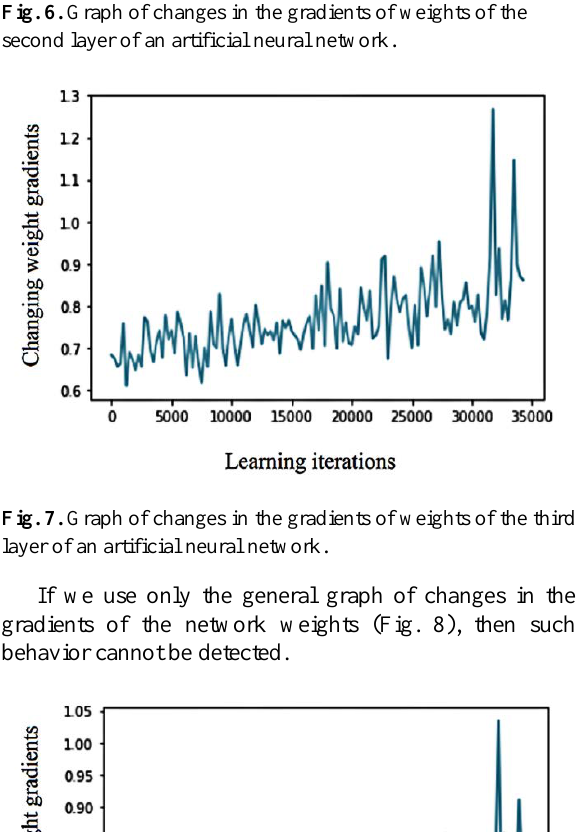
Fig. 6. Graph of changes in the gradients of weights of the second layer of an artificial neural network .